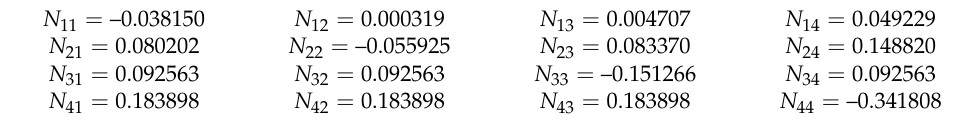
Table 16. Four-group fluxes